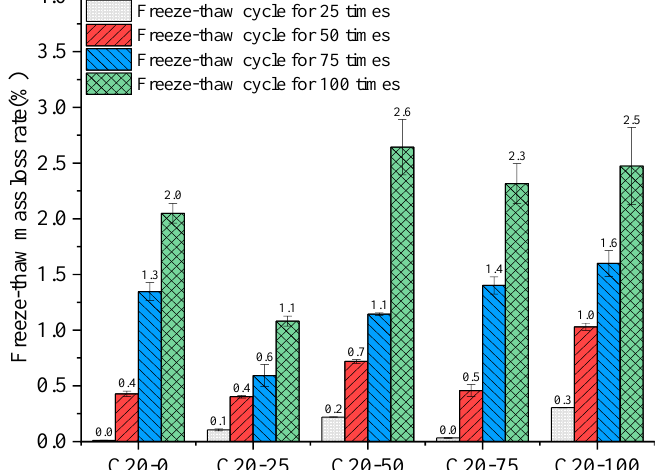
Figure 16. Mass loss rate of C20 concrete under freeze – thaw cycles. To sum up, replacing 25%, 50%, and 75% of potable water with wastewater can im- prove the frost resistance of C20 concrete and reduce the freeze – thaw failure rate. How- ever, excessive wastewater, such as a 100% proportion of wastewater as a replacement for potable water, can accelerate the damage rate of C20 concrete. The reasons may be as fol- lows. When the temperature is lower than 0 °C, the water in the capillary pores starts freezing, forcing the excess water to flow to larger pores [46]. At the same time, the water tends to move to the surface and freeze, causing the sample to dry [47] and forming